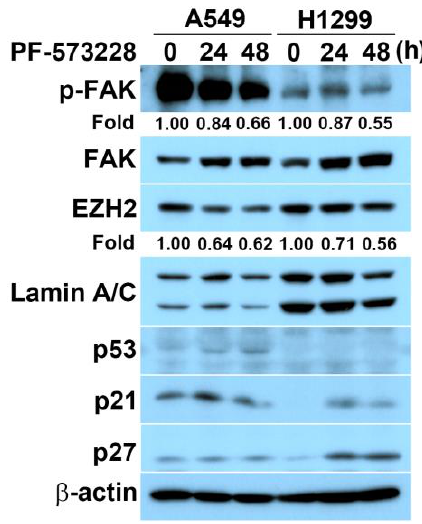
Figure 1. FAK inhibition reduces EZH2 expression and elicits DNA-damage signaling. A549 or H1299 cells were exposed to 10 µ M PF-573228 for the indicated time, followed by lysate harvesting. It was subjected to immunoblotting for the indicated proteins. As a loading control, an anti- β -actin antibody was used. The numbers below the blot images indicate the relative intensity of pY397 FAK or EZH2 signal relative to the β -actin signal.